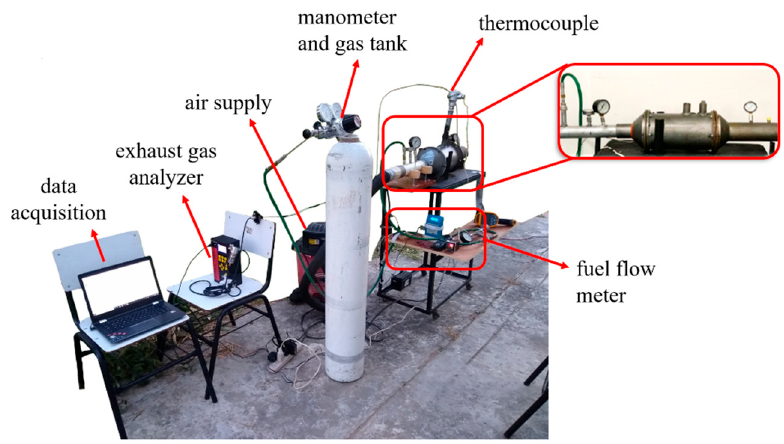
Figure 16. Test Figure 16. Test rig.